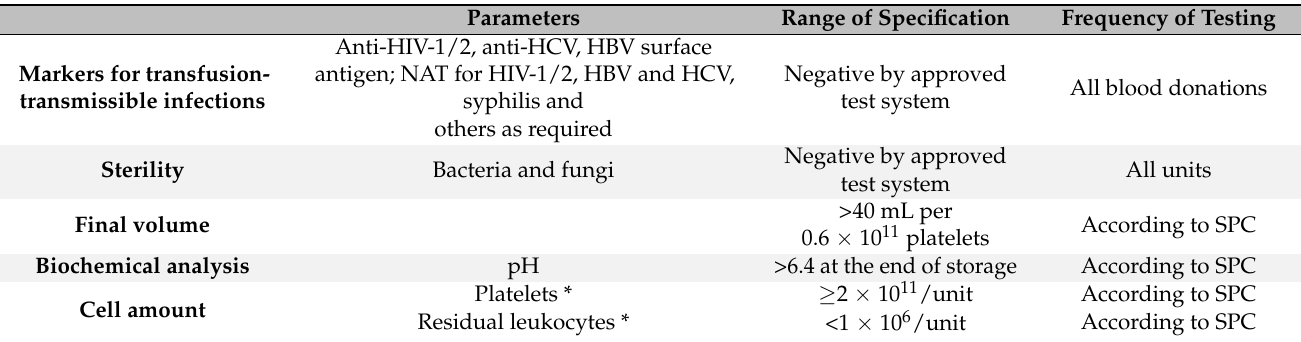
Table 1. European quality parameters for platelet concentrates (modified from [21,22]). * A minimum of 90% of units tested should meet the required value. Abbreviations: HIV-1/2, human immunodeficiency virus type 1 or type 2; HCV, hepatitis C virus; HBV, hepatitis B virus; SPC, statistical process